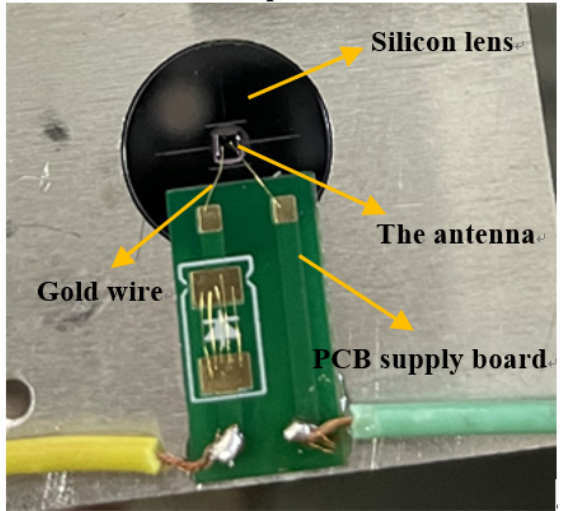
Figure 4. Photograph of the THz photoconductive emitter for measurement. The THz time domain spectroscopy (TDS) system shown in Figure 5 was used to measure the proposed PCA and conventional PCA. The fabricated PCAs were placed at the focal point of the laser at the transmitter. Since the THz radiation signal generated by the antenna was very small, an ultra-low-noise current amplifier was used here to linearly amplify it.